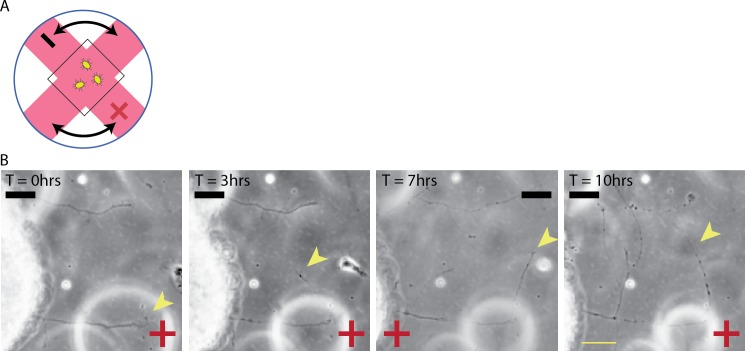
RGC axons shift direction of growth in response to acute changes in EF angle. (A) Schematic of electrotaxis chamber that allowed EF polarity to be changed by 90°. (B) Explants were grown for 12 hours, then exposed to an EF of 200 mV/mm (T = 0). Cathode-directed growth can be seen at T = 3 hours. At T = 4 hours, the direction of the EF was shifted 90° clockwise and the RGC axon can be seen shifting toward the “new” cathode at T = 7 hours. At T = 7 hours, the cathode was shifted 90° counterclockwise, and at T = 10 hours, the RGC axon again shifted its growth toward the “new” cathode. See Supplementary Video S2. (Yellow arrowhead points to representative growth cone.) Yellow scale bar: 50 μm.